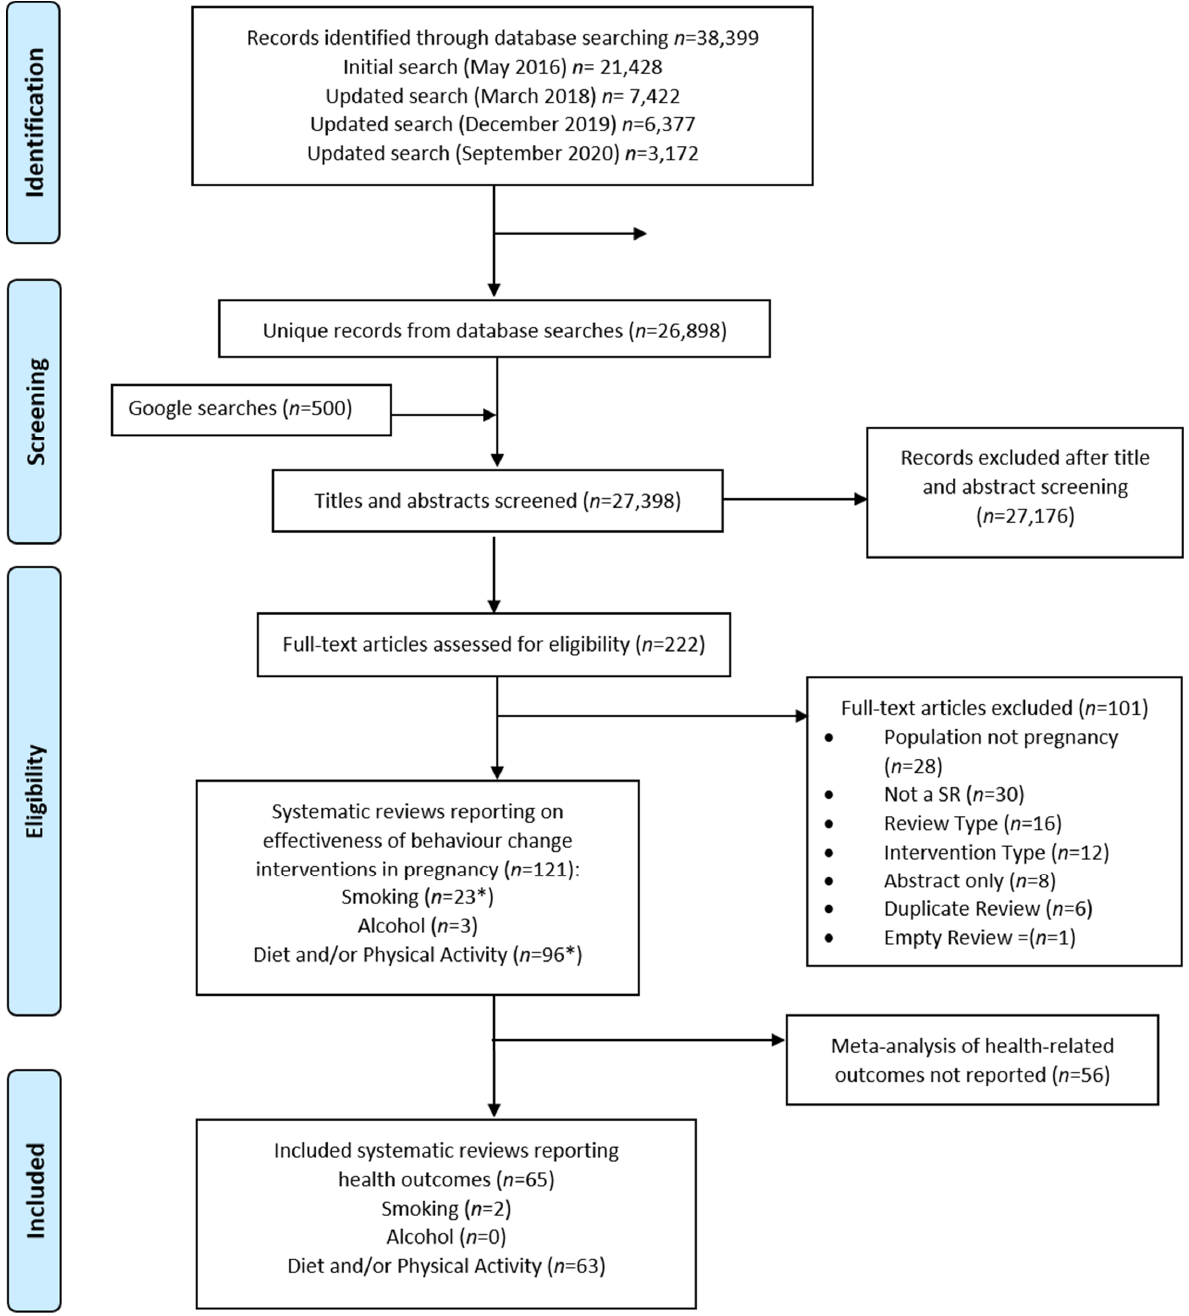
Figure 1. PRISMA Flowchart.* One systematic review included both smoking and diet and/or physical activity intervention studies. Table 1. Summary data for included systematic reviews.